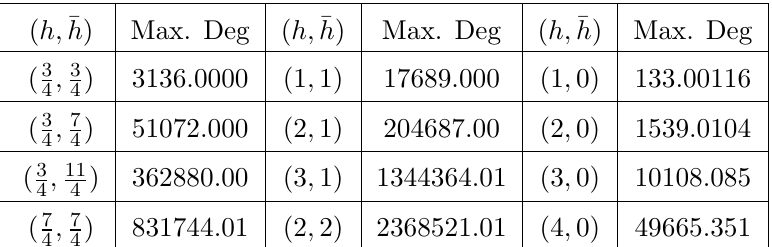
The solutions to (2.7) with c = 7 are known to agree with the b E with a = 0